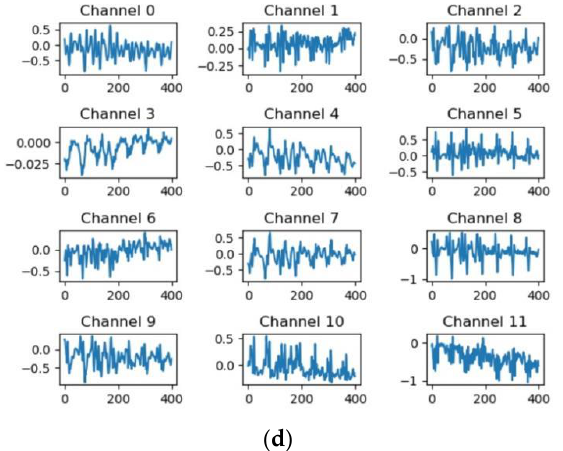
Figure 3. The MESA’s visual feature map of the first convolutional layer for the different residual modules whose kernel size is 5 samples, 11 samples, and 21 samples, respectively. ( a ) A random ECG sequence for MESA, ( b ) feature maps extracted by residual modules whose kernel size is 5, ( c ) feature maps extracted by residual modules whose kernel size is 11, and ( d ) feature maps extracted by residual modules whose kernel size is 21.